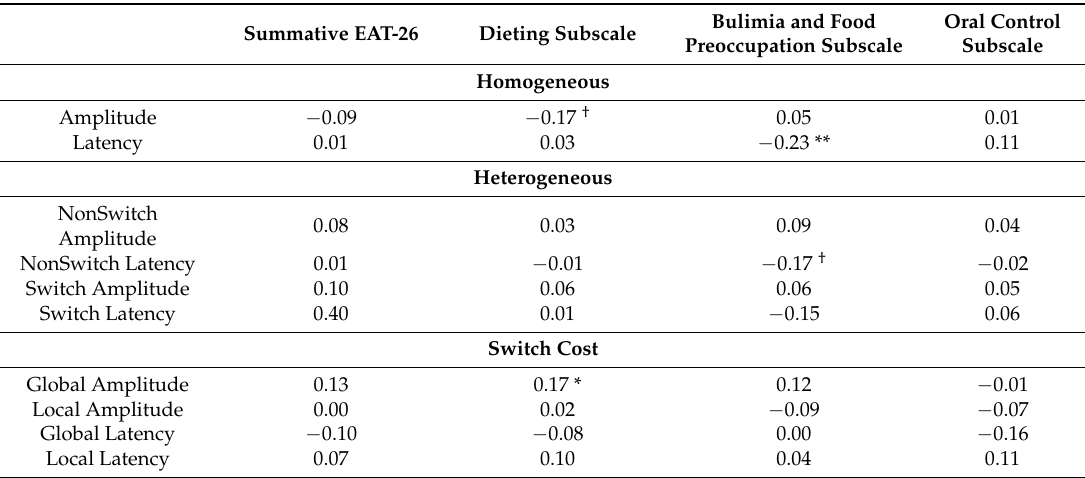
Table 3. Bivariate Correlations between EAT-26 variables and Switch task ERP